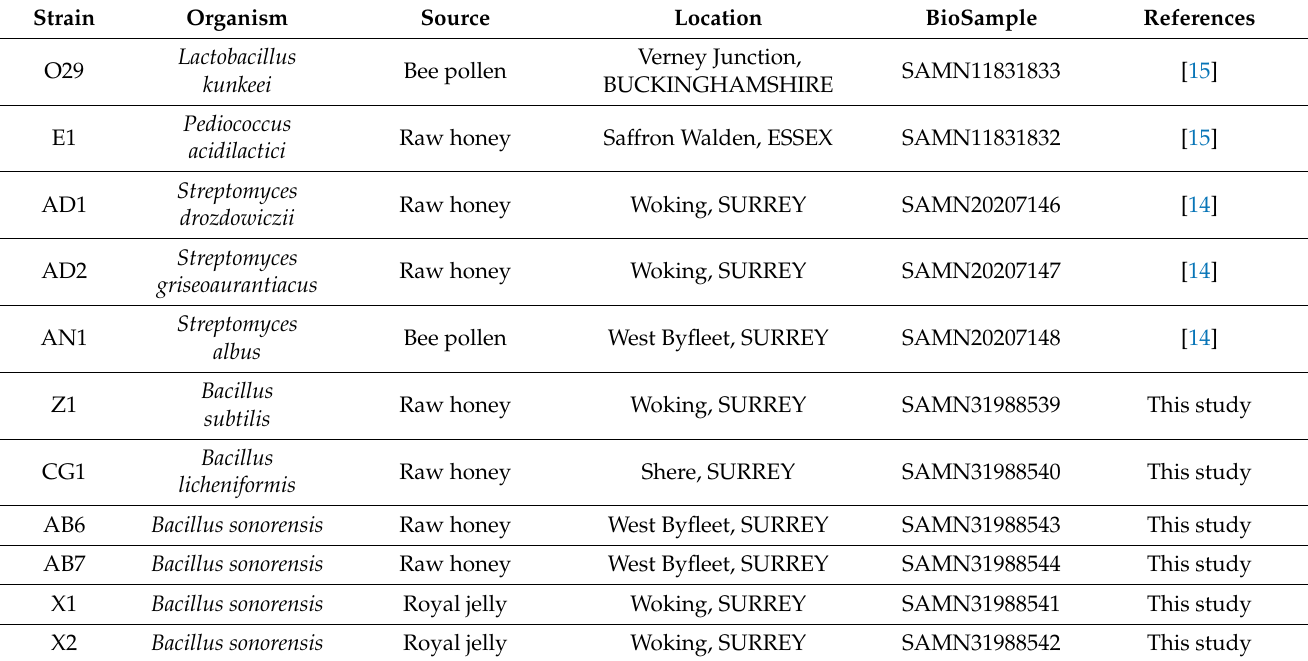
Table 1. Strains isolated from honeybee samples in South England and characterized in this and previous studies.